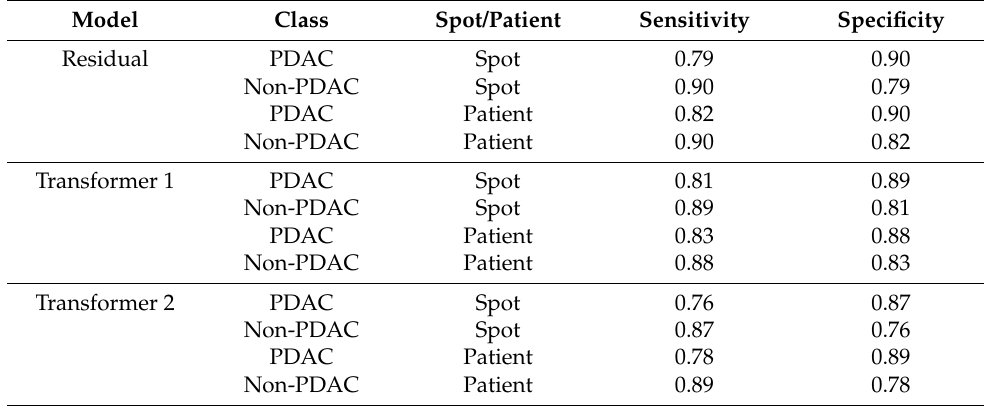
Table 6. Sensitivity and specificity metrics distinguished by histotype (PDAC and non-PDAC). Non- PDAC denotes all tumor and non-PDAC types labeled in the given data set. Reported are the results for all